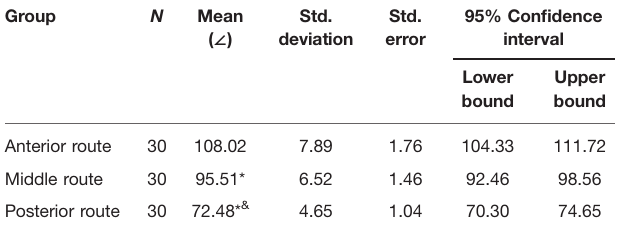
TABLE 2 | Included angle of the CC7 nerve via three prespinal